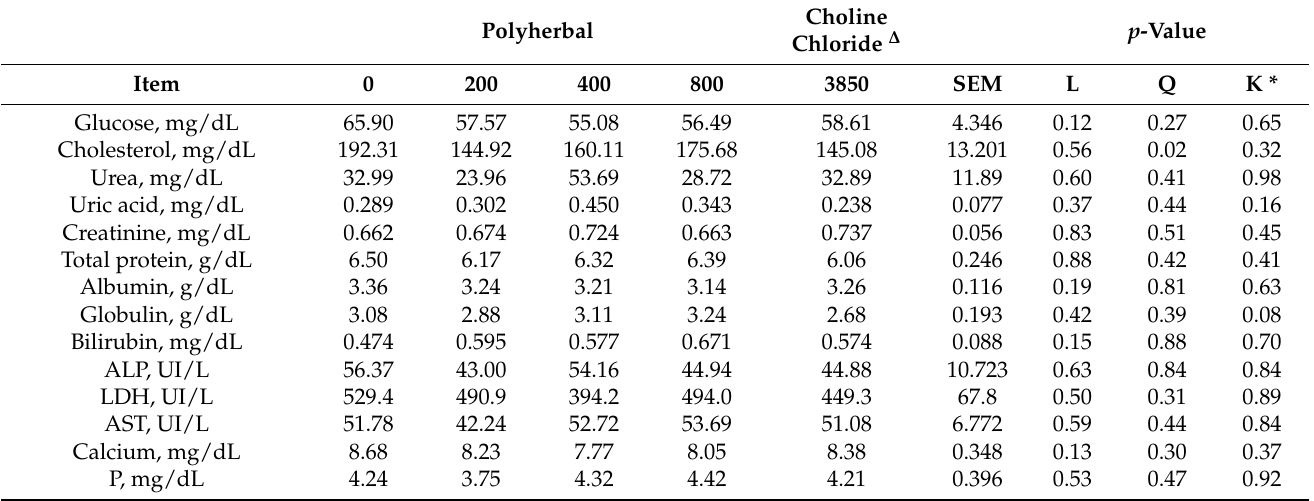
Table 2. Effect of the polyherbal level and choline chloride (mg/kg) on the blood chemistry of dogs. Polyherbal